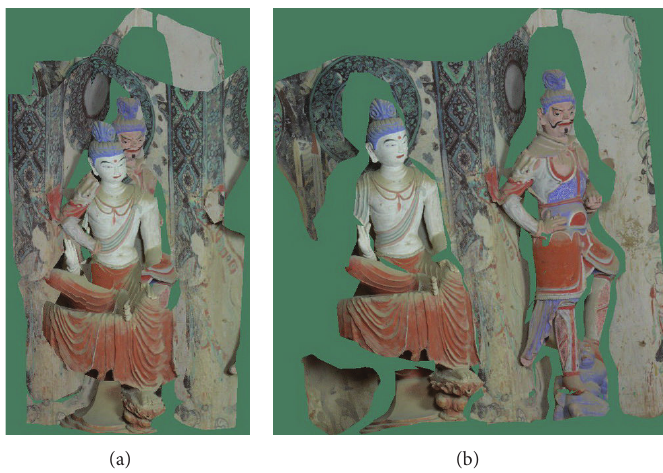
Figure 6: 3D model stitching effect: (a) the initial model and (b) after